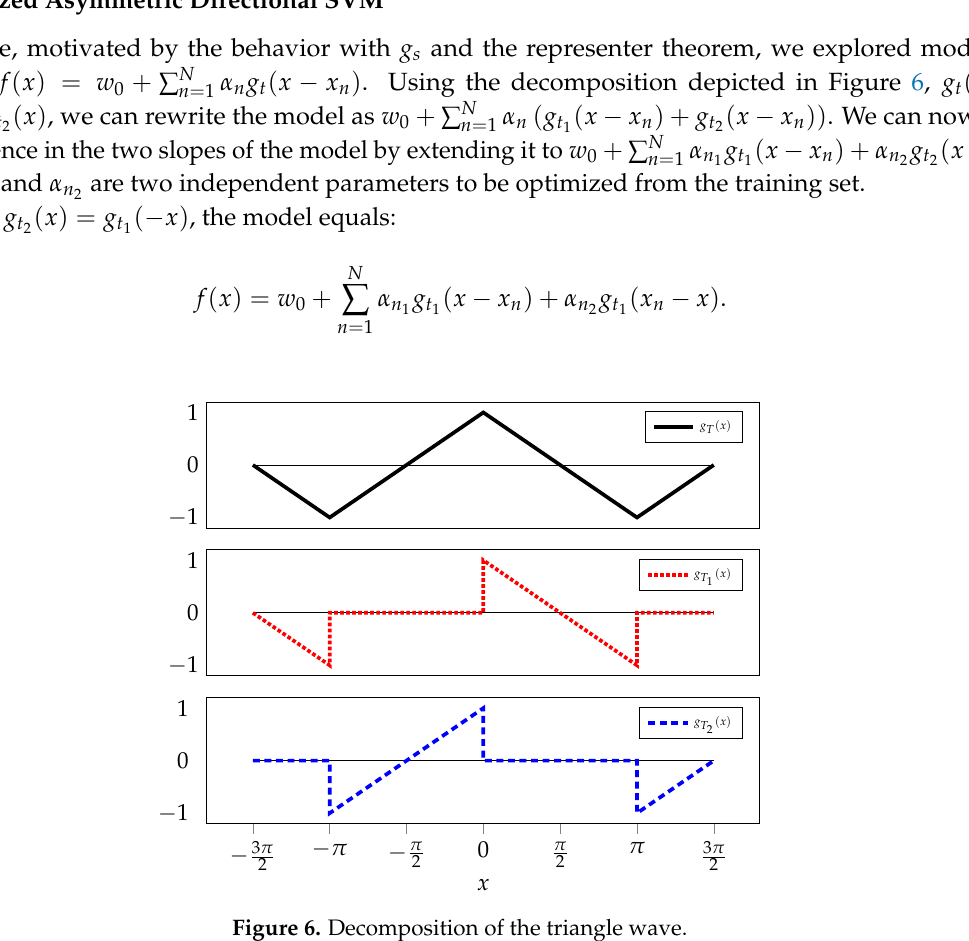
example where the fitted Figure 4. Toy symmetric model does not provide an appealing solution.